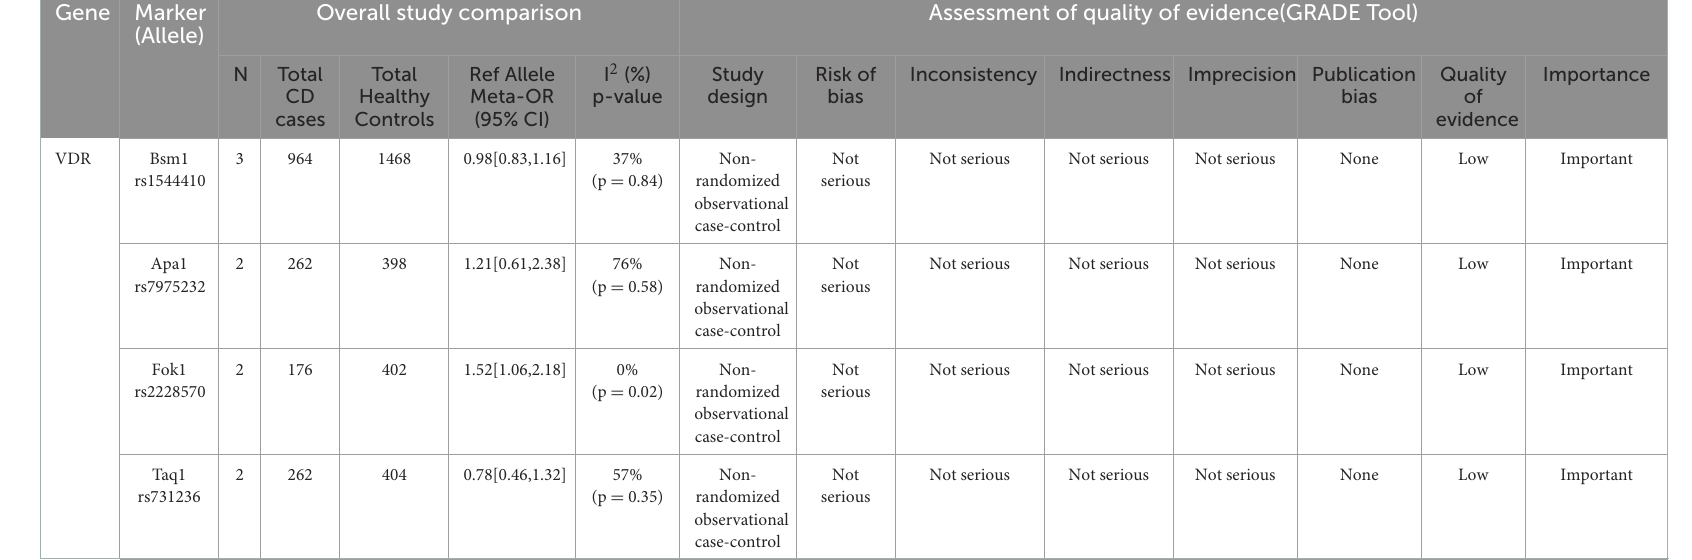
TABLE 1 Summary table of the alleles included in the meta-analysis and the quality of evidences as graded by the GRADE tool. Gene Marker